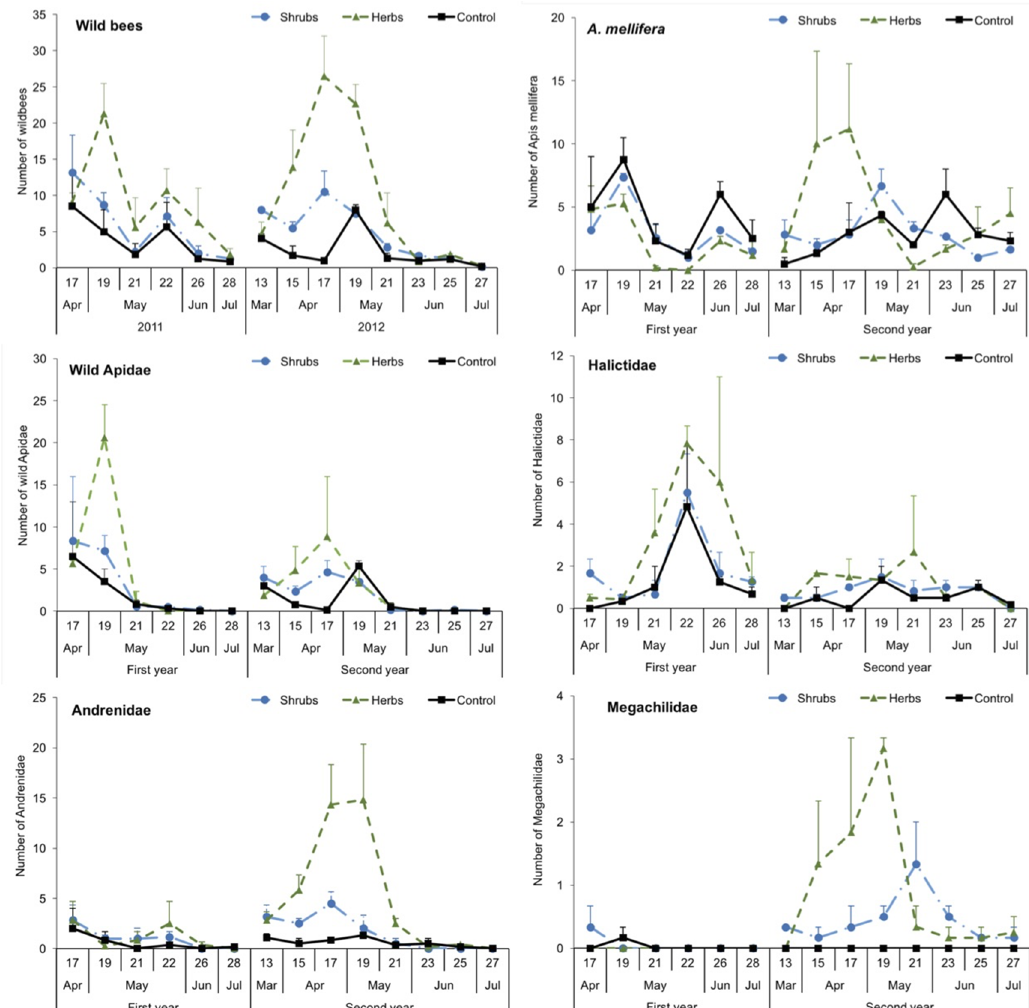
Figure 2. Trends in the numbers of wild bees (means ± SE), A. mellifera , wild Apidae, Halictidae, Andrenidae and Megachilidae captured in pan traps in shrubby, herbaceous and control margins. The numbers in the abscise (x) axe indicate the week of the year.